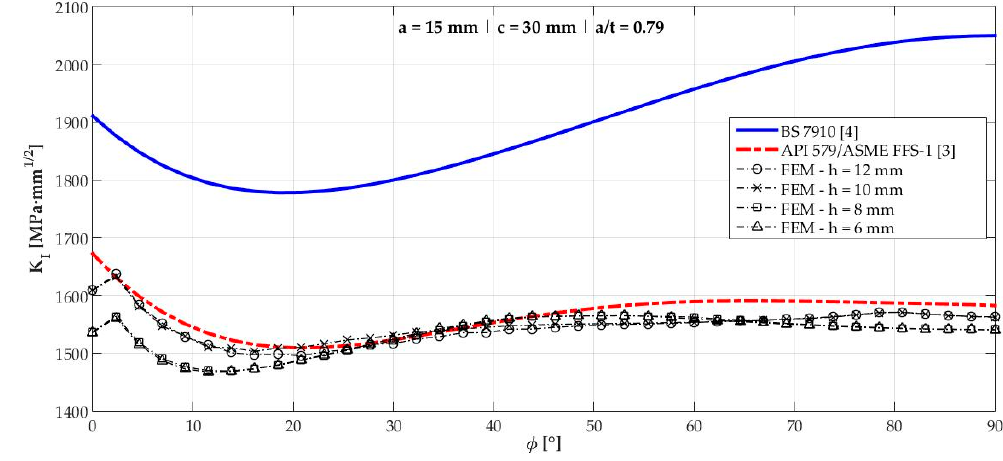
Figure 10. Mode I SIF profiles for crack 5 ( a = 15 mm , c = 30 mm , and a/t = 0.79 ).